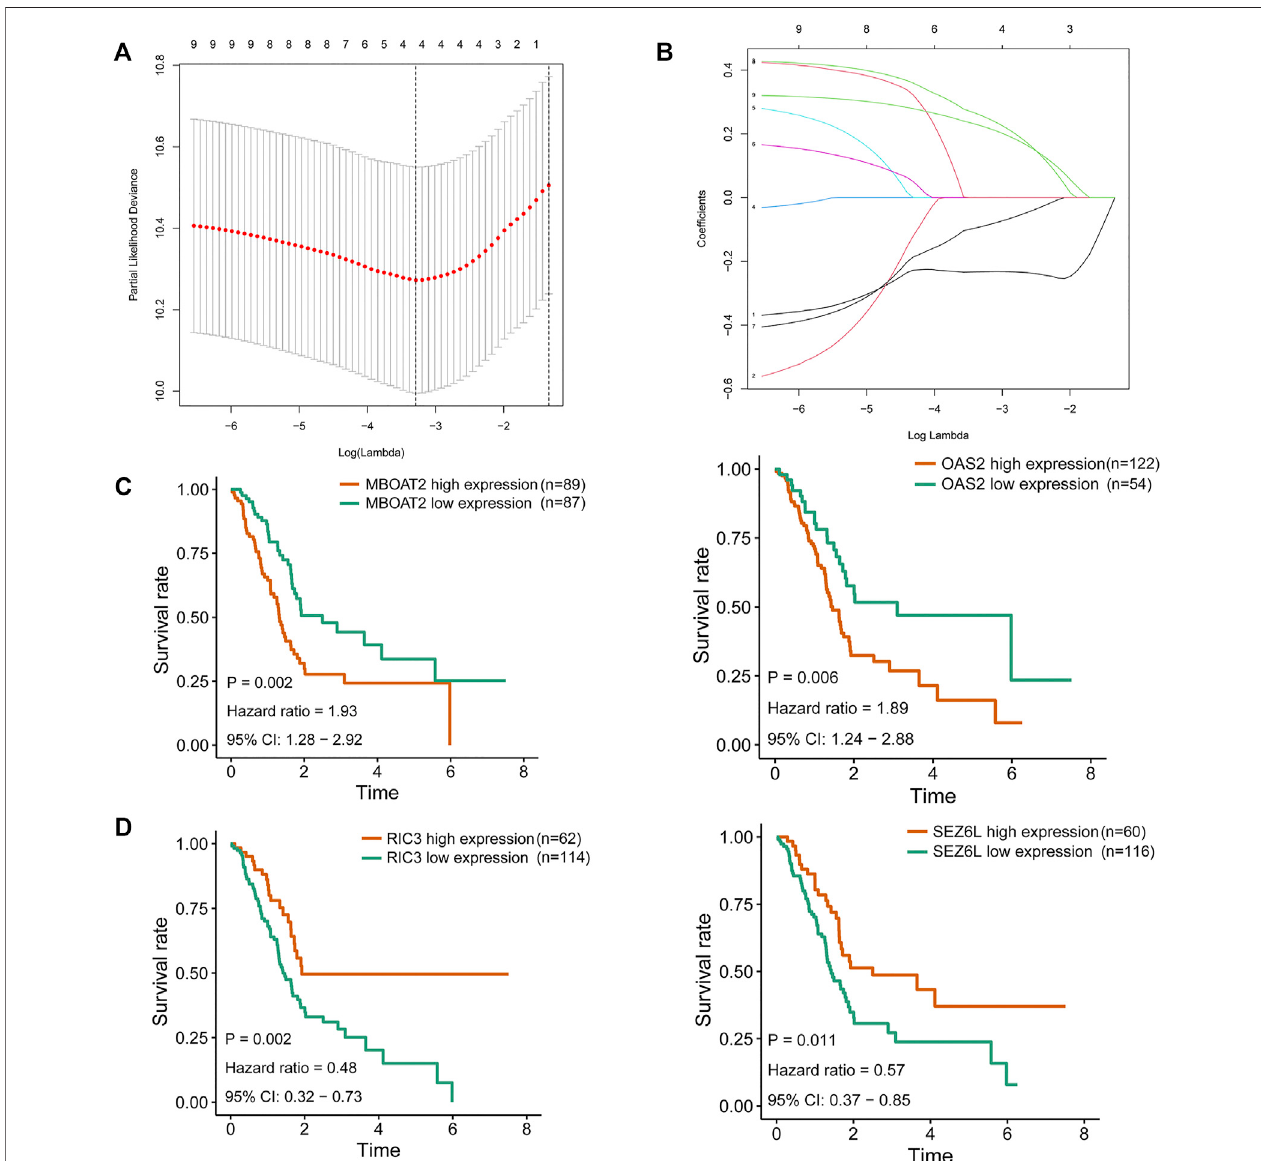
FIGURE 4 | Identi fi cation of DNA methylation-driven gene for predictive signature and corresponding survival analysis. (A) Filtration of the optimal number of DNA methylation-driven genes by 1,000 iterations of Cox LASSO regression with ten-fold cross-validation. (B) Ultimate four genes of nonzero coef fi cients are selected as candidateDNA methylation-drivengenes. (C) K-M survivalcurvesforMBOAT2 and OAS2ofwhichthe expression wasnegatively correlated withOSinPCpatients. (D) K-M survival curves for RIC3 and SEZ6L of which the expression was positively correlated with OS in PC patients. LASSO, least absolute shrinkage and selection operator; K-M, Kaplan – Meier; OS, overall survival; PC, pancreatic cancer.